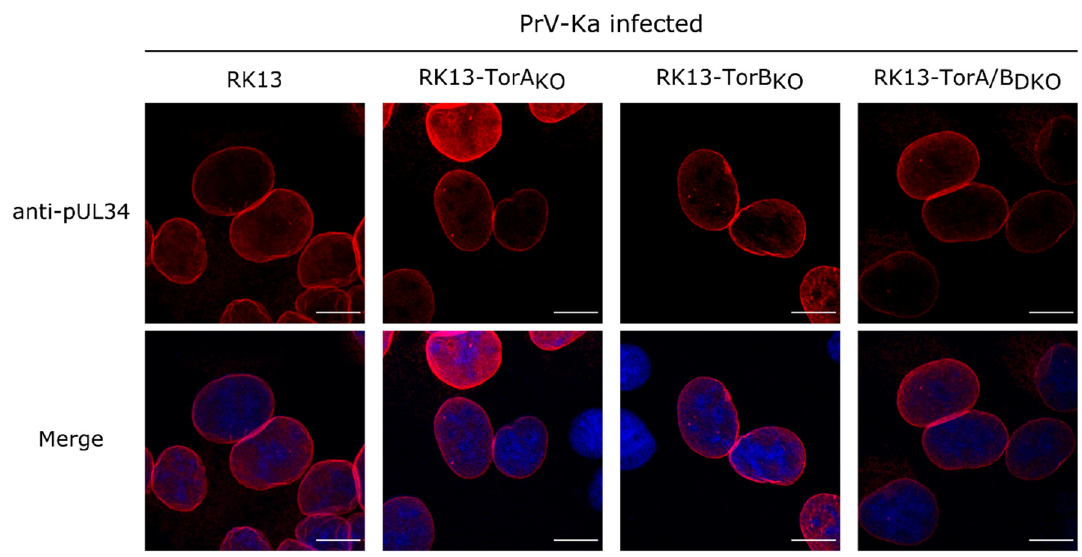
Figure 9. Localization of the NEC component pUL34 in PrV-Ka infected RK13 and Torsin KO cells. Representative images showing undisturbed localization of the NEC component pUL34 (red) in infected RK13-Torsin KO cells. Nuclei were counterstained with DAPI (blue) and the fluorescence was imaged with a confocal laser scanning microscope. Scale bars indicate 10 µm.